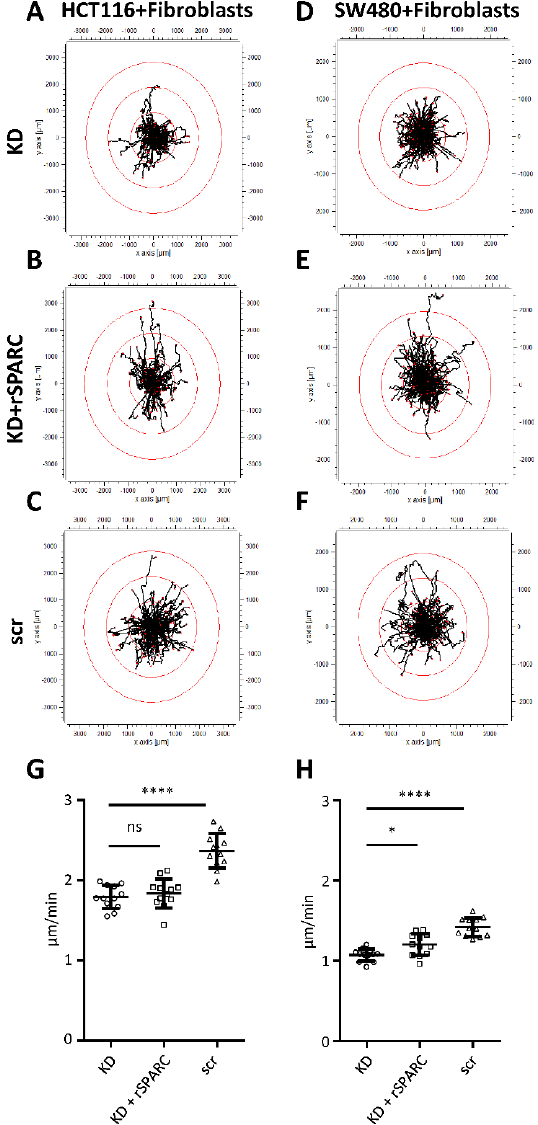
Figure 5. Influence of fibroblast derived SPARC on cancer cell migration. F331 fibroblasts transfected with either scr control, SPARC siRNA (KD) or KD cells with additional rSPARC were seeded at high numbers and allowed to secrete and modulate their respective ECM. After 5 days, cancer cells were added on top of the fibroblast monolayers and migration of individual cells was recorded for a total of 22 h. ( A – C ) shows the resulting tracks for HCT116 cells migrating on F331 with KD, KD + rSPARC and scr control. Similar tracks for SW480 cells are summarized in ( D – F ). Red circles indicate track length based on maximum Euclidian distance and were positioned at 50%, 100% and 150% of the longest track of the KD group. The average migration speed in µ m / min of HCT116 ( G ) and SW480 ( H ) was plotted as mean values for each well ( n = 10) of 2 independent experiments using 2 di ff erent siRNAs. Statistical analysis for di ff erent migration velocities was performed by using the Kruskal-Wallis test followed by Dunn’s multiple comparisons test. *: p < 0.05; ****: p < 0.0001. Scatter dot plots: center line,